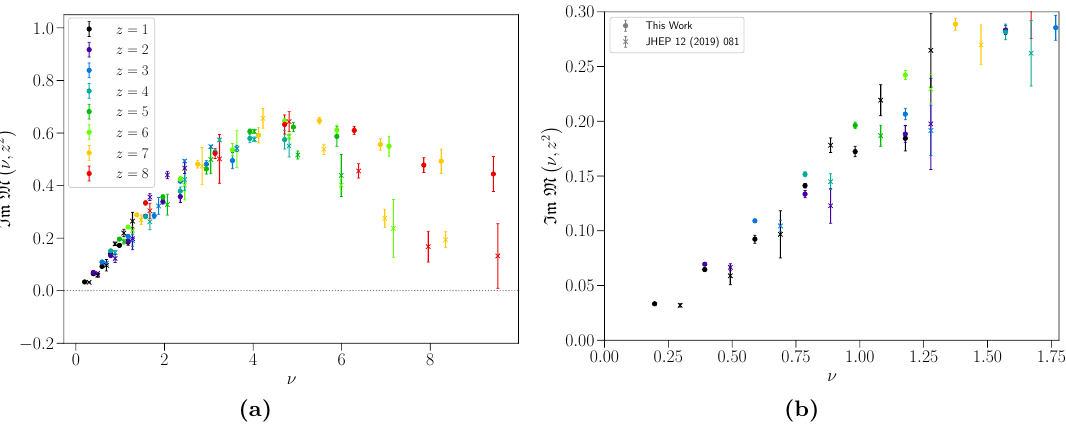
Figure 28. (a) The imaginary component of the Ioffe-time pseudo-distribution computed in this work (circles) compared with the results of ref. [58] using Jacobi smearing (crosses). (b) Focusing on the small- ν region, the improvements afforded by distillation are seen to be considerable. Data from ref. [58] has been shifted horizontally for